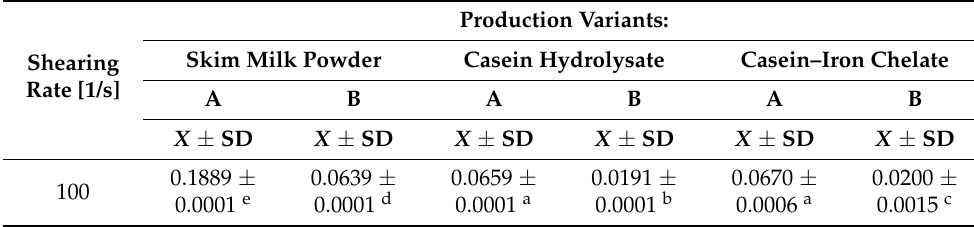
Production Variants: Casein